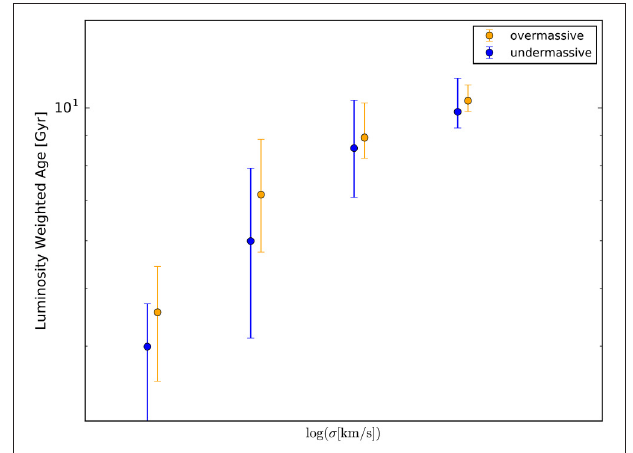
FIGURE 2 | M BH − σ relation at z ∼ 0. Red points are model result, and black thick line describes the fitting function of the model result. Blue line is the fitting function of the data obtained from van den Bosch (2016).